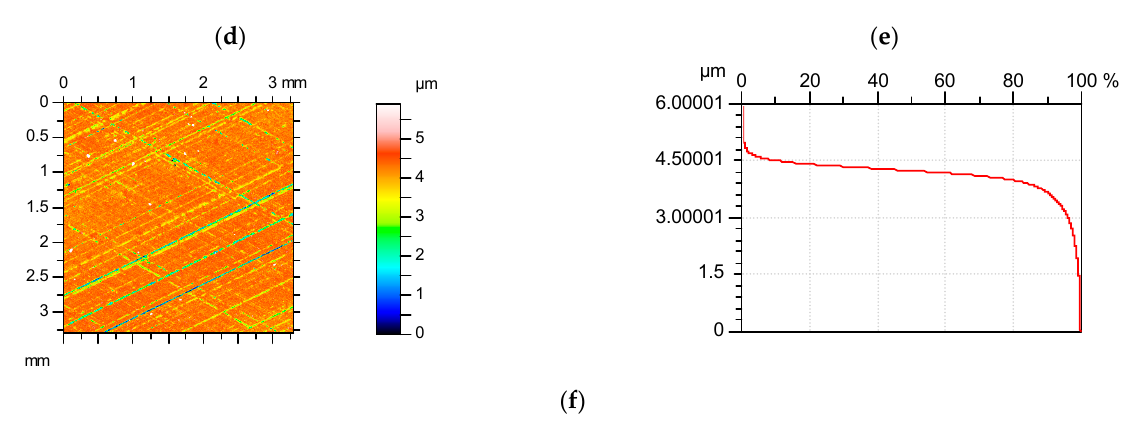
Figure 5. Contour plots ( a , d ), material ratio curves ( b , e ), and selected parameters ( c , f ) of the plateau- honed cylinder surface, with ( a – c ) and without spikes ( d – f ).